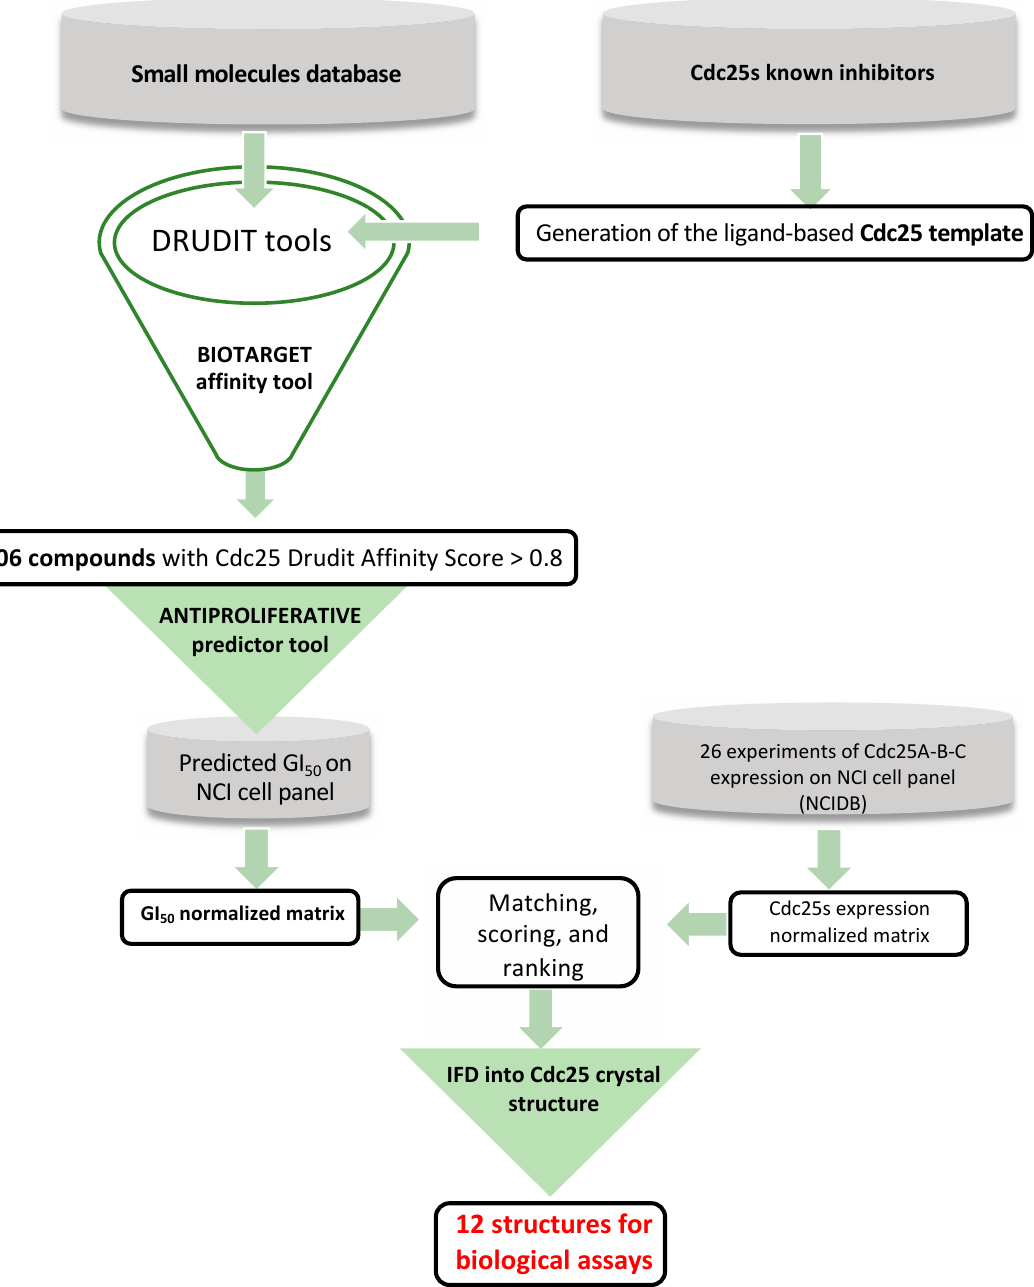
Figure 4. The in silico protocol aimed at identifying new Cdc25 inhibitors from a database of purchasable compounds (Sigma-Aldrich).